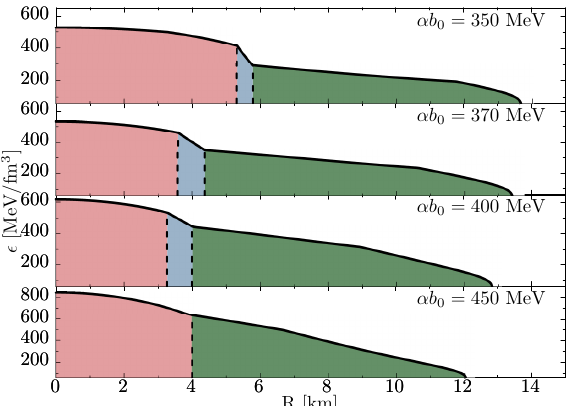
Figure 5. Profiles of the energy density for neutron stars with M = 2.05 M (cid:12) for m 0 = 790 MeV, for four different cases α b 0 = 350,370,400,450 MeV. The green regions show the phase where the chiral symmetry is broken; in the red regions, chiral symmetry is restored, whereas the blue regions indicate the regions of coexistence of both phases (mixed